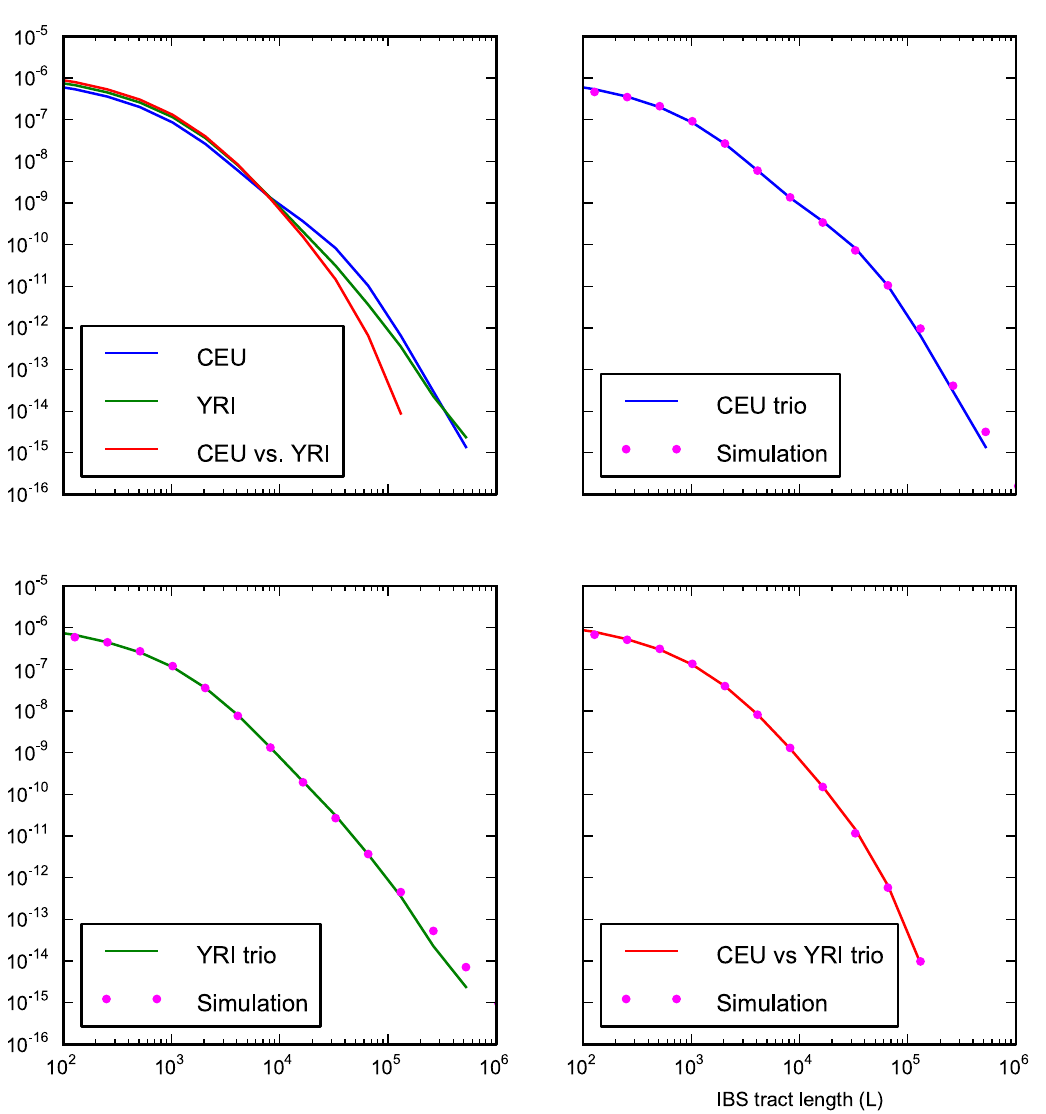
Figure 8. Accurate prediction of IBS sharing in the trio data. The upper left hand panel summarizes IBS tracts shared within the European and Yoruban 1000 Genomes trio parents, as well as IBS tract sharing between the two groups. The remaining three panels compare these real data to data simulated according to the history from Figure 7 with the maximum likelihood parameters from Table 2.